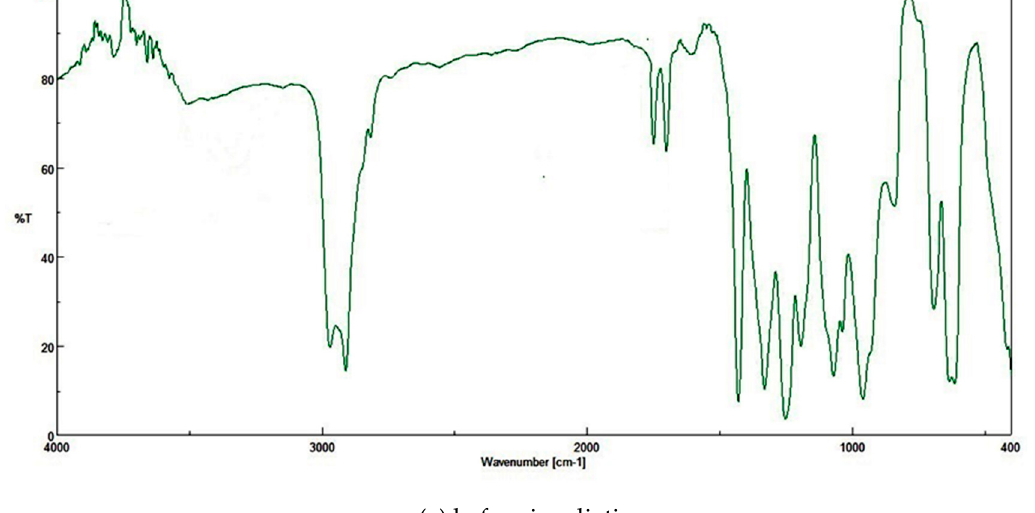
Figure 2. Cont. Figure 2.